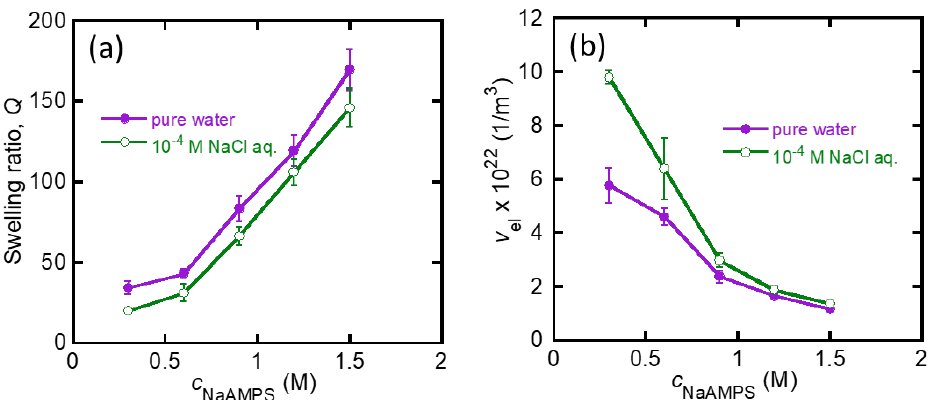
Figure 2. ( a ) Relationship between the swelling ratio, Q , and c NaAMPS of the St-tetra-PEG gels in pure water or 10 − 4 M NaCl aqueous solution; ( b ) relationship between the number density of the elastically effective network strands, υ el , and c NaAMPS of the same St-tetra-PEG gels.